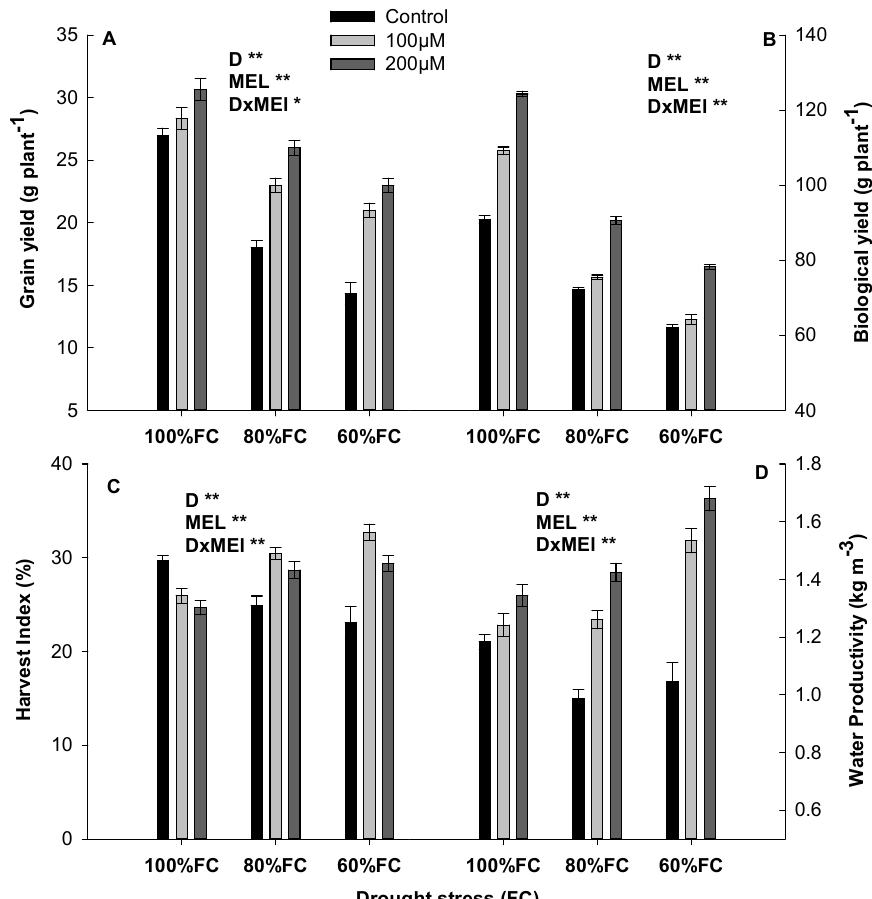
Figure 3 . Changes in ( A ) grain yield; ( B ) biological yield; ( C ) harvest index; and ( D ) water produc- tivity of maize with root application of MEL under drought. 100% FC represent no stress, 80% FC represents mild stress, and 60% FC represents severe stress. Error bars represent standard error of replicates. ** represents significant difference at 1% level of probability. D represents drought stress levels, while MEL represents MEL Levels, and D x MEL is the interaction between both factors.